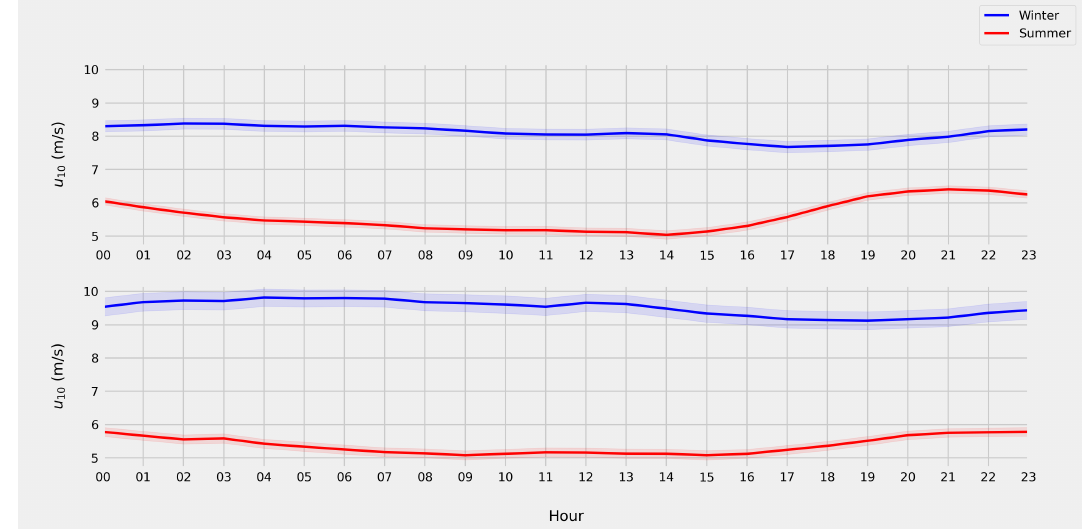
Figure 13. ( Top ) BUZM3 Station and ( Bottom ) Buoy 44017 diurnal variability; 1999–2019 average with 95% confidence